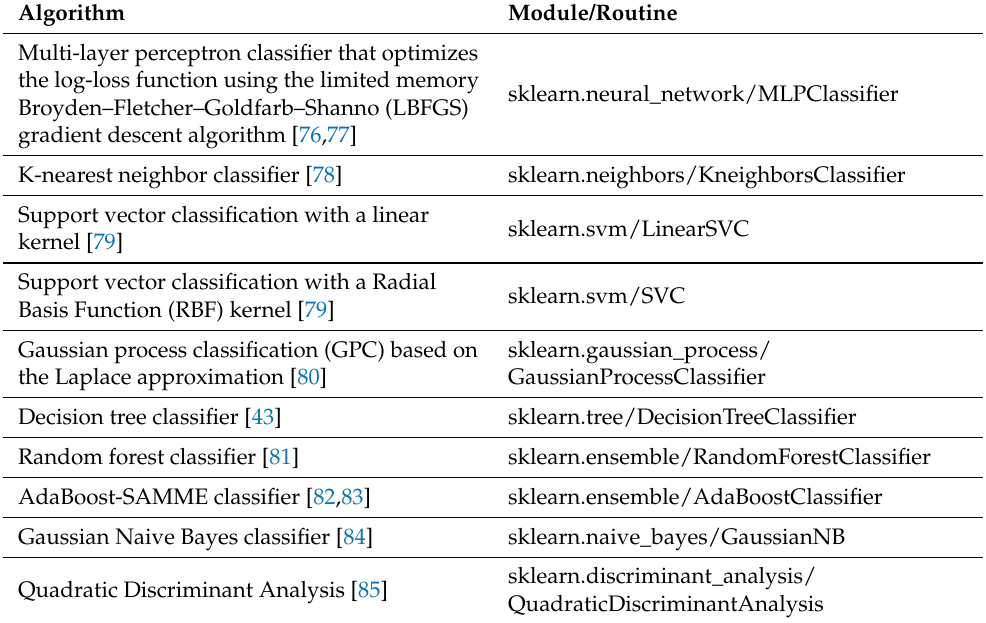
Table 1. The list of scikit-learn classification routines used for benchmarking with the VEOR algorithm.